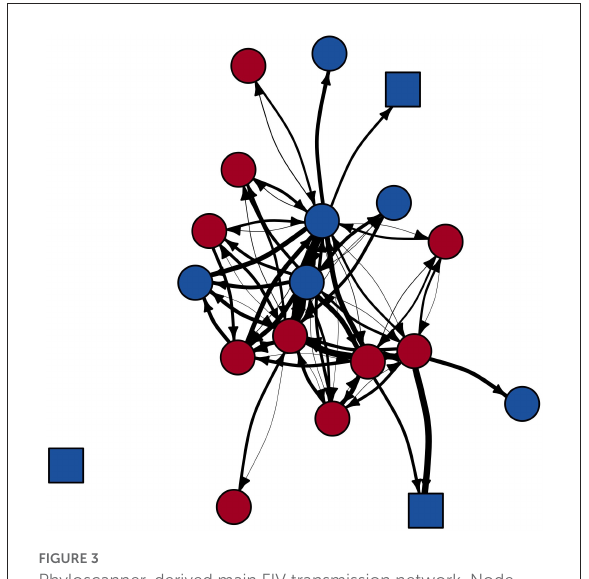
FIGURE3 Phyloscanner-derived main FIV transmission network. Node shape indicates panther age class (square = subadult; circle = adult). Node color indicates panther sex (blue = male; red = female). Edge weight represents Phyloscanner tree support for each edge (thicker edge = increased support); for visualization